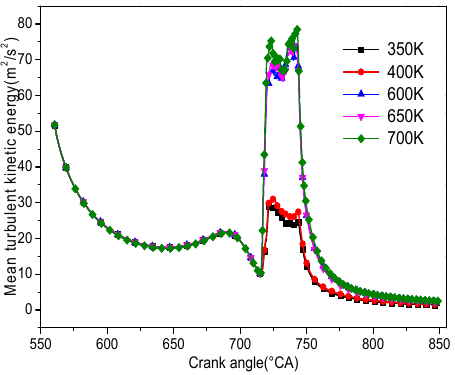
Figure 7. Change curve of mean turbulent kinetic energy.